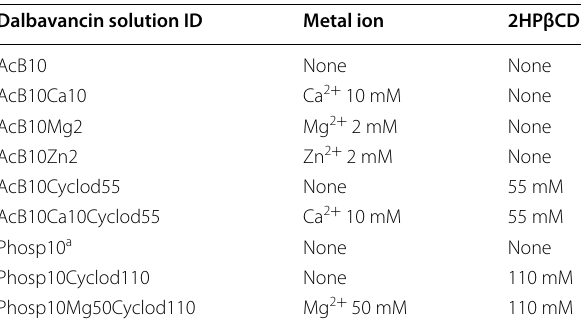
Table 1 Composition of 20 mg/mL (11 mM) dalbavancin liquid formulations in 10 mM acetate buffer (pH 4.5) and 10 mM phosphate buffer (pH 7.0)